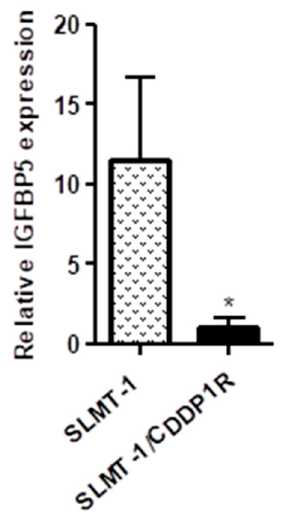
Figure 2. Validation of insulin-like growth factor binding protein 5 ( IGFBP5 ) expression by quantitative real-time polymerase chain reaction (qPCR) analysis. Relative expression level of IGFBP5 in SLMT-1/CDDP1R was significantly lower than SLMT-1.Relative IGFBP5 expression in SLMT-1/CDDP1R was determined by comparing with SLMT-1, after normalized with the expression of β -actin. * p < 0.05.